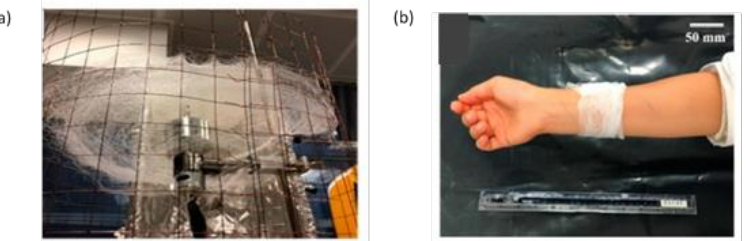
Figure 19. Bandage-like fibrous scaffold fabrication ( a ) simple centrifugal spinning system ( b ) image of the prepared sample as wrapped around an arm. Reproduced with permission from [159], copyright 2019 MDPI.